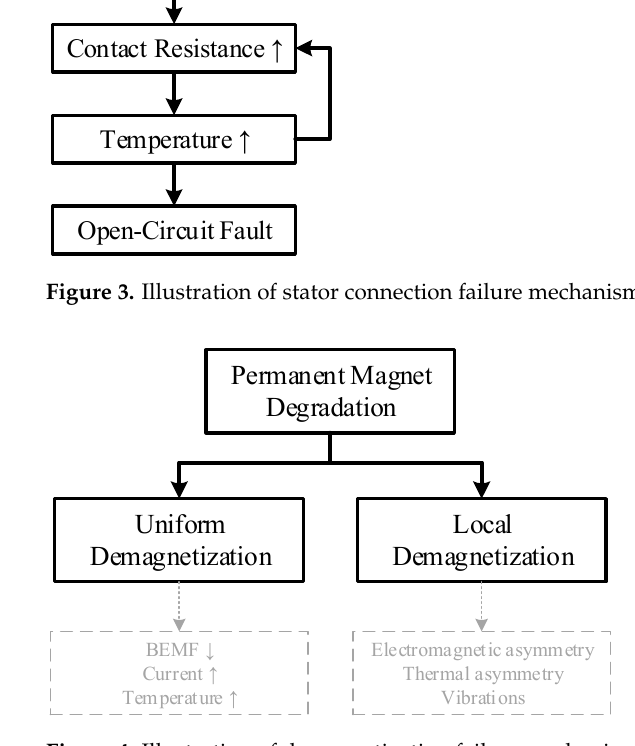
Figure 4. Illustration of demagnetization failure mechanism.